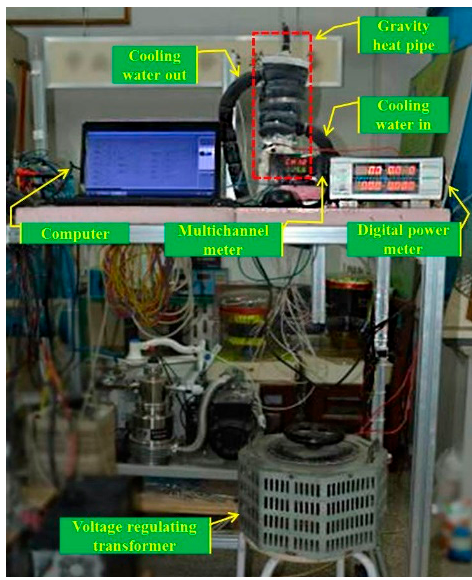
Figure 4. Image of the experimental system.